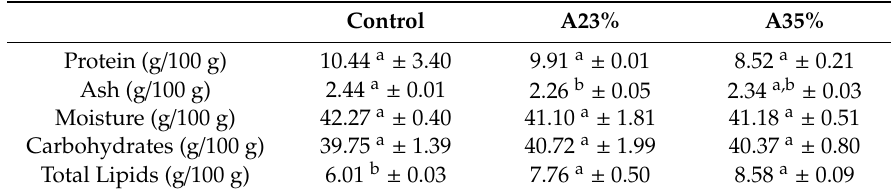
Table 2. Nutritional composition of GFB with the incorporation of di ff erent ratios of acorn flour (A23% and A35%) and comparison with control